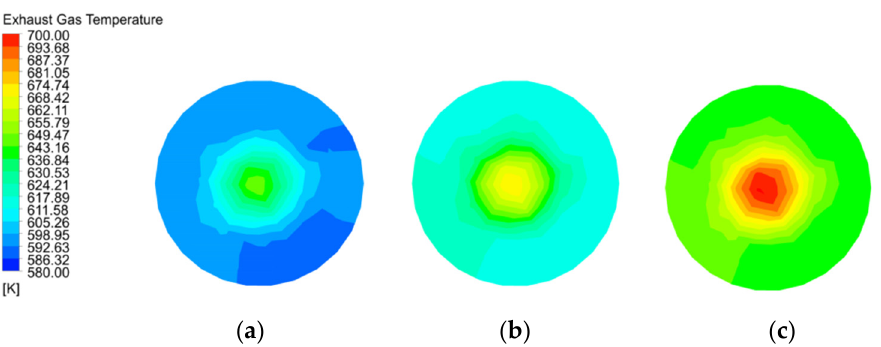
Figure 10. Gas temperature distribution and variation in exhaust gas outlet at 40 mm, 80 mm and 120 mm particle sizes. ( a ) Gas temperature in exhaust gas outlet of 40 mm; ( b ) Gas temperature in exhaust gas outlet of 80 mm; ( c ) Gas temperature in exhaust gas outlet of 120 mm.